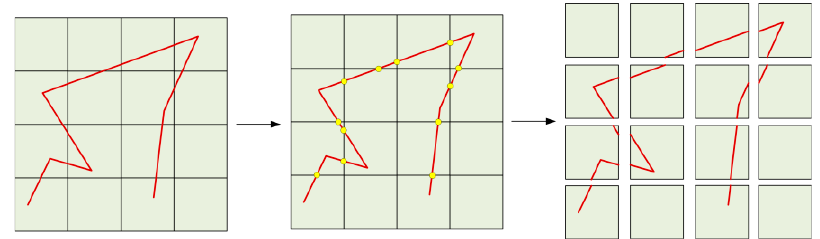
Figure 3. Segmentation of polylines.